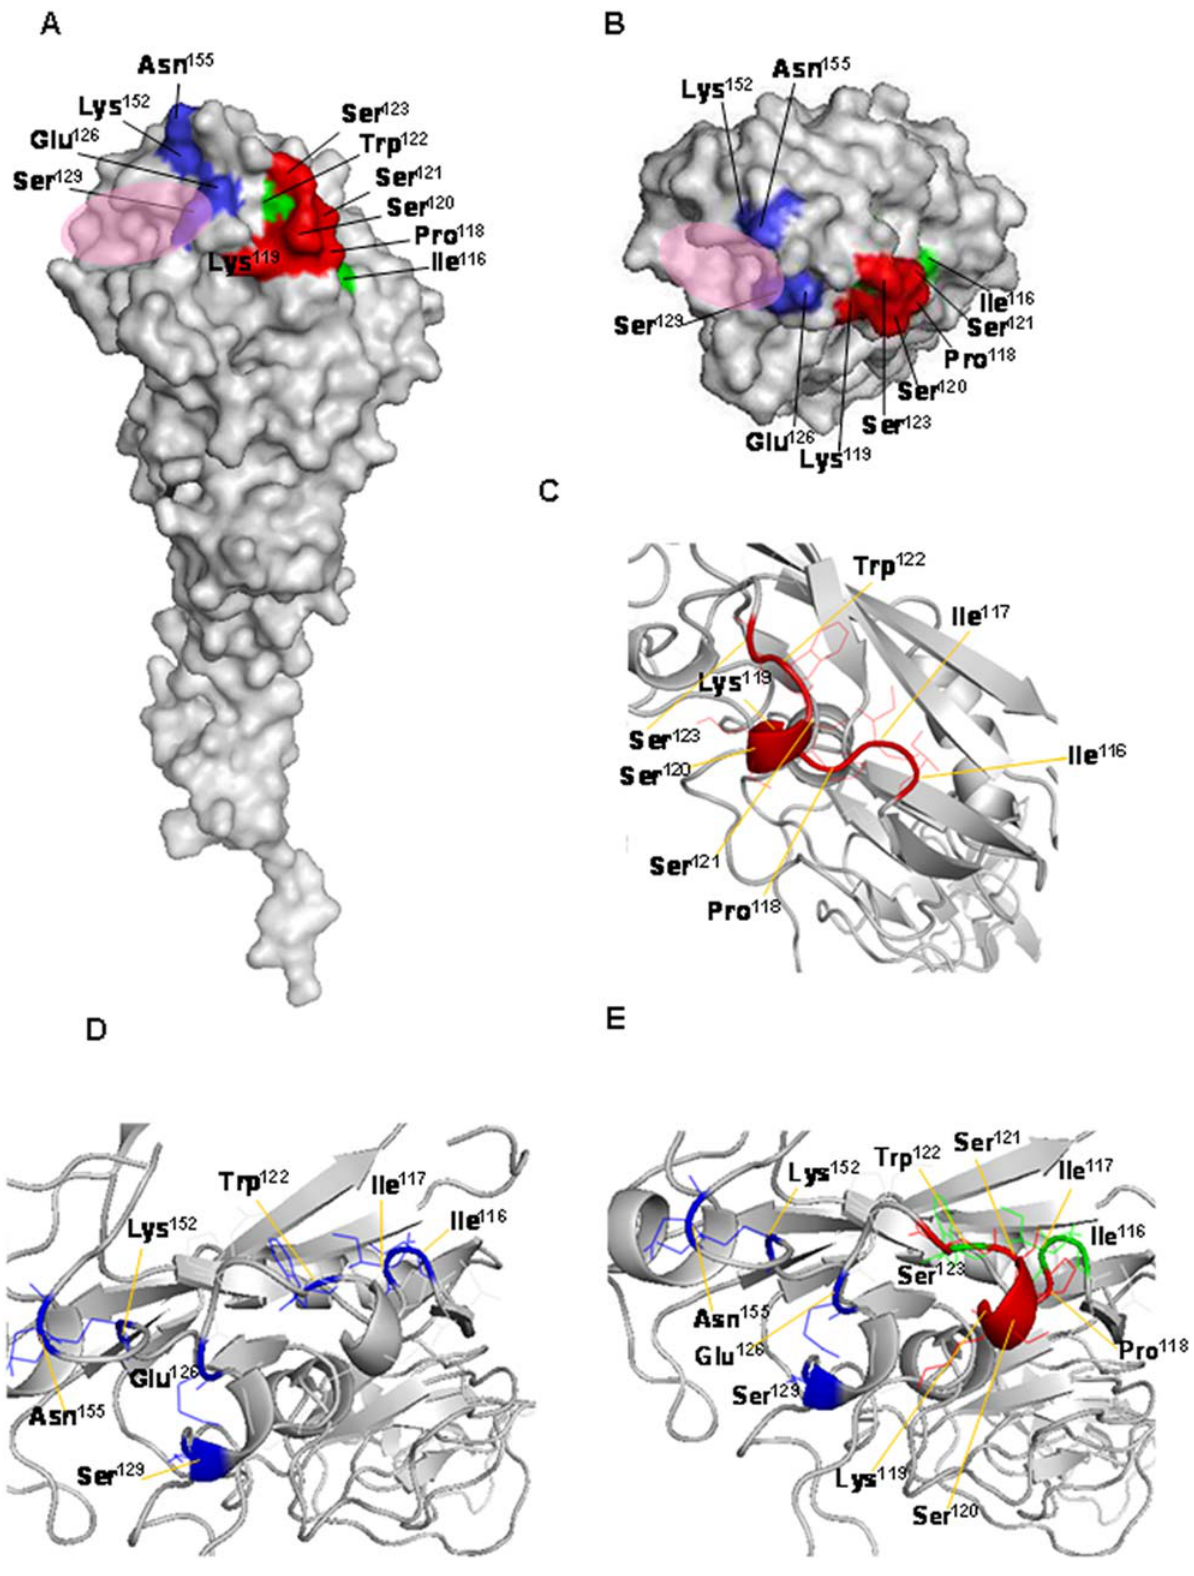
Figure 4. Schematic representation of the epitopes recognized by AVFluIgG01 and AVFluIgG03 on the globular head of the H5 AH/ 1/05 HA1 molecule. Amino acid positions are designated in H5 numbering. A linear epitope (IIPKSSWS, amino acid 116–123) recognized by AVFluIgG01 is colored in red; non-continuous conformational epitope of AVFluIgG03 is colored in blue; the overlapping binding site for both AVFluIgG01 and AVFluIgG03 are colored in green. The receptor binding domain (RBD) is highlighted with a purple oval. (A) Side view of the HA1